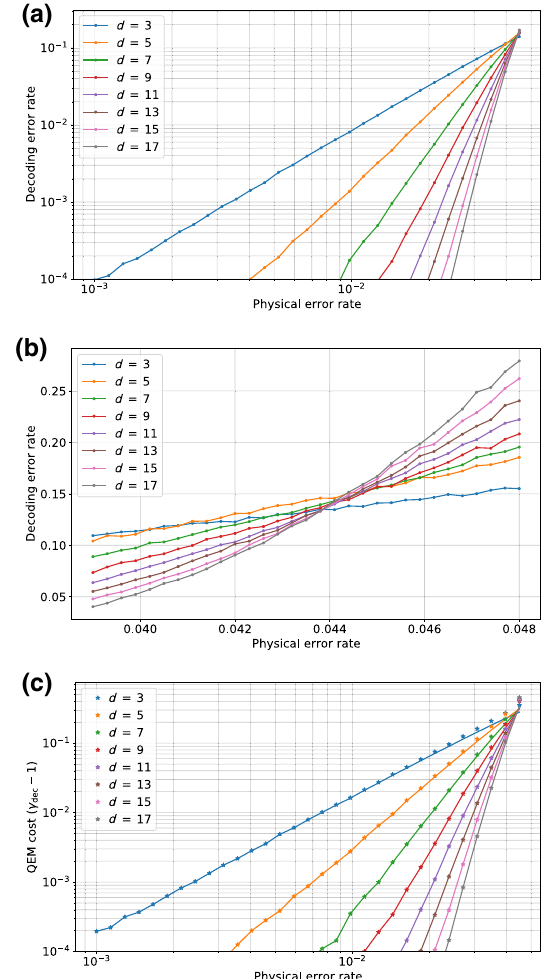
FIG. 4. Logical error probability and QEM cost for d -cycle syndrome measurements plotted against the physical error rates at several code distances. (a) Logical error probability as a func- tion of physical error rate. (b) The same figure enlarged around the threshold value. (c) QEM costs for d -cycle idling